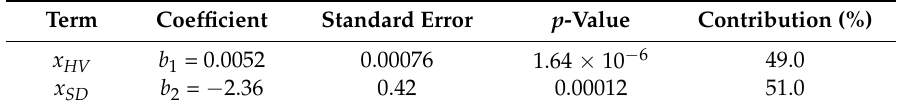
Table 7. The regression coefficients, standard errors, p -values and contributions for the model of case depth with the non-ground sample data set. The intercept term is b 0 = − 4.73.